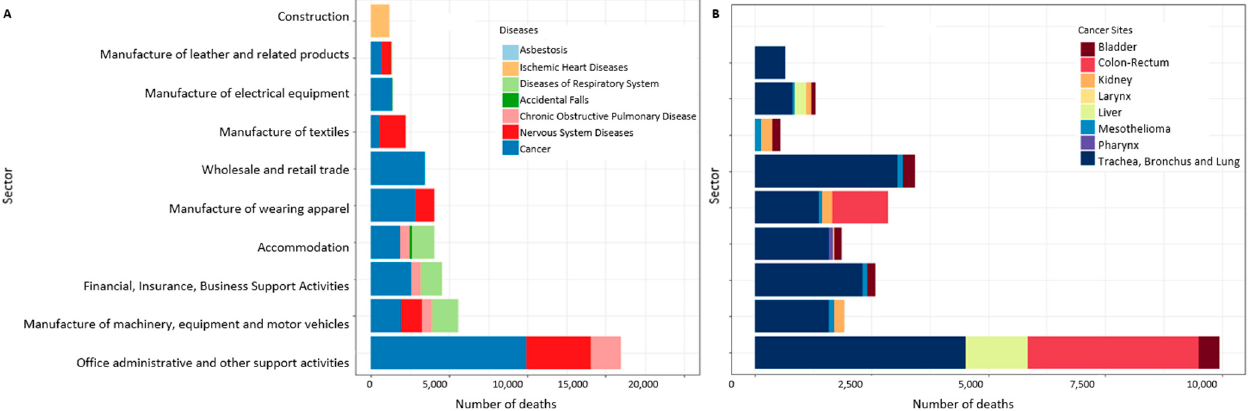
Figure 2. Number of deaths with PMR > 1 by economic sector and diseases or cancer sites in females (( A ) diseases; ( B ) cancer sites). The PMR was calculated considering the longest duration of employ- ment.